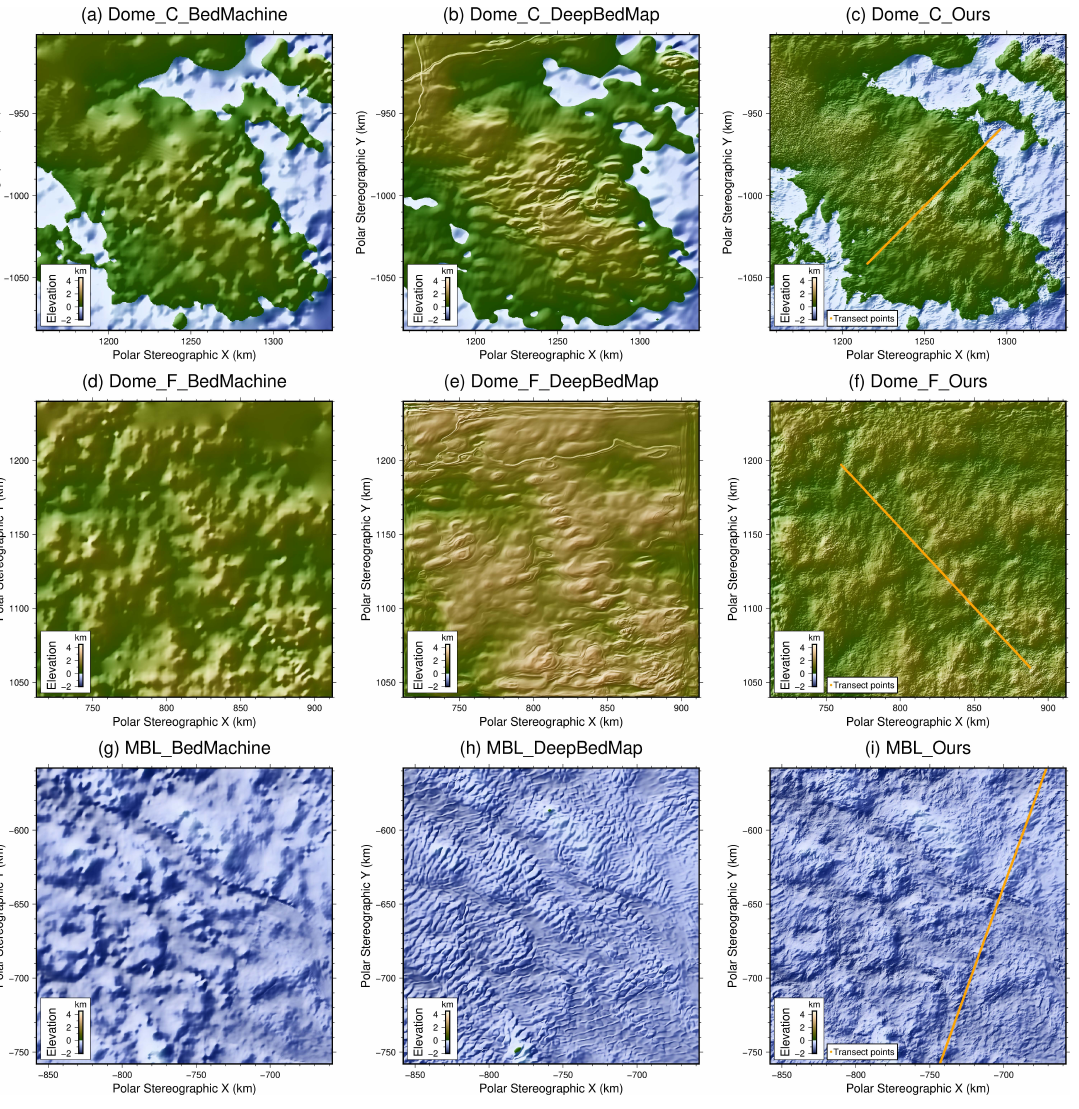
Figure 11. Bed topography comparison of BedMachine, DeepBedMap, and MB_DeepBedMap grid products. ( a – c ) show Dome C location; ( d – f ) show Dome F location; ( g – i ) show Marie Byrd Land (MBL) location. Orange lines in ( c , f , i ) correspond to the transect in Figures 11–13,